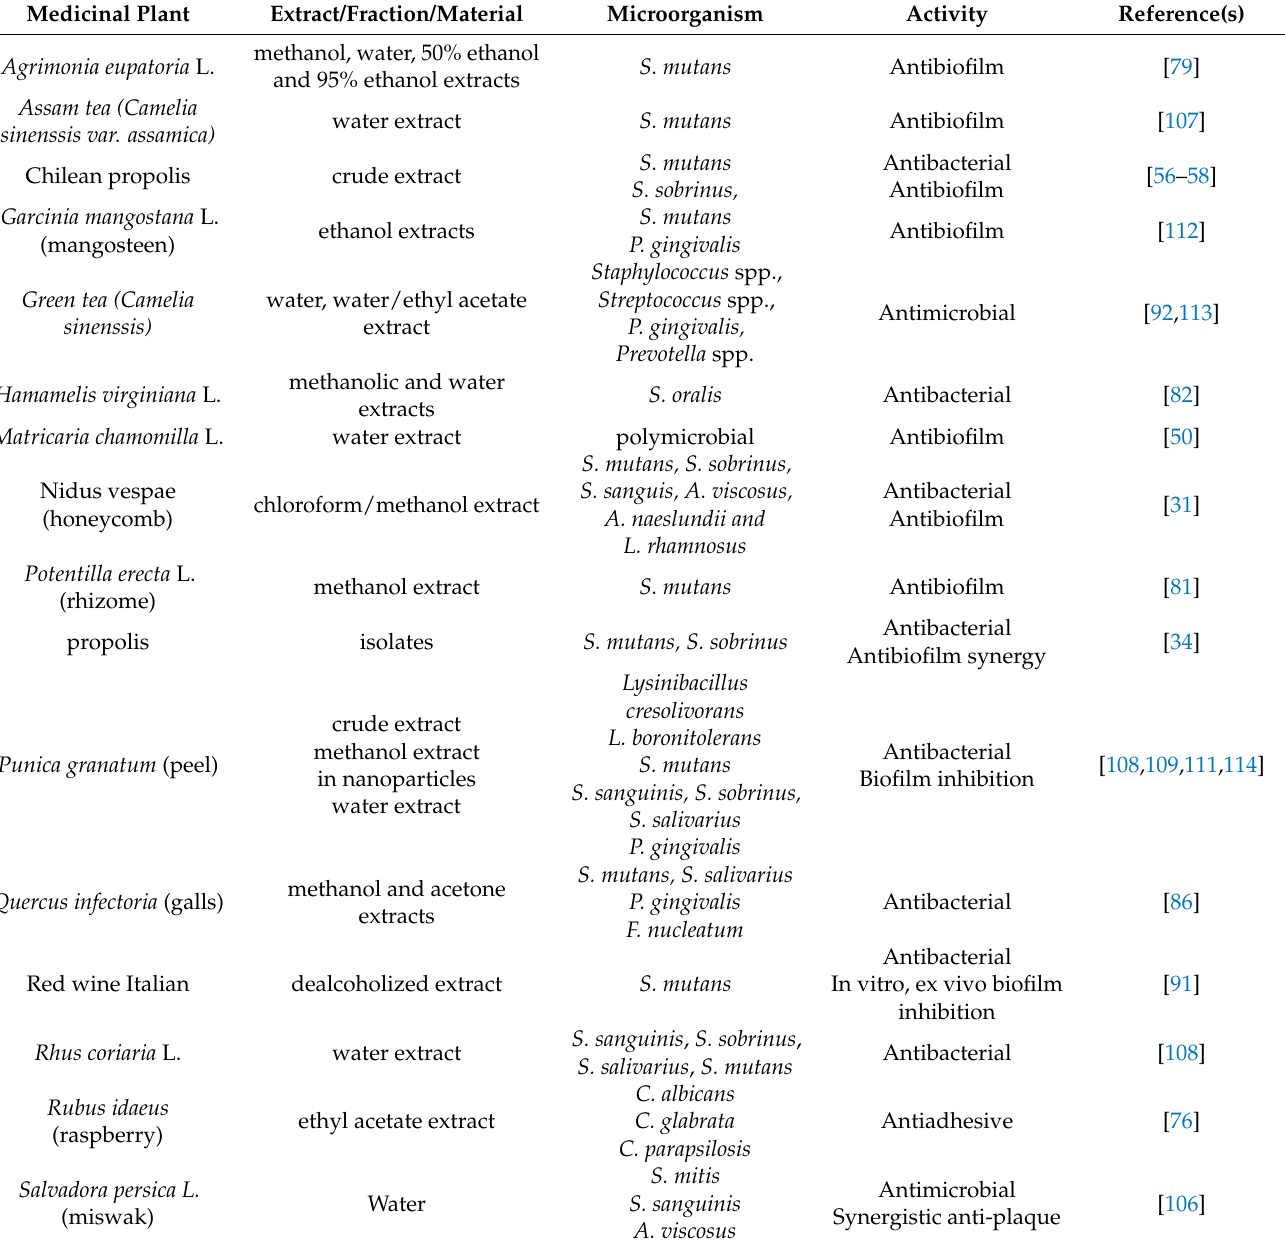
Table 5. Medicinal plants and natural products rich in flavonoids and tannins as therapeutic agents in oral